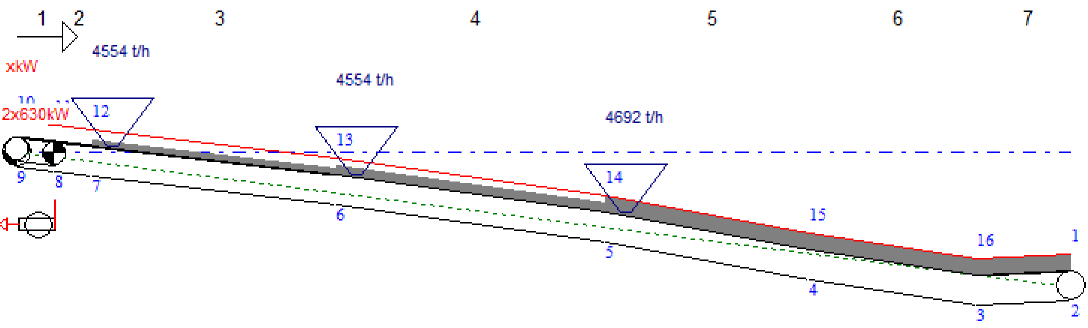
Figure 5. The profile of the study route of the overburden conveyor on the ramp, receiving overburden at three loading points on three subsequent mining levels, which is discharged at its head (source: QNK-TT).